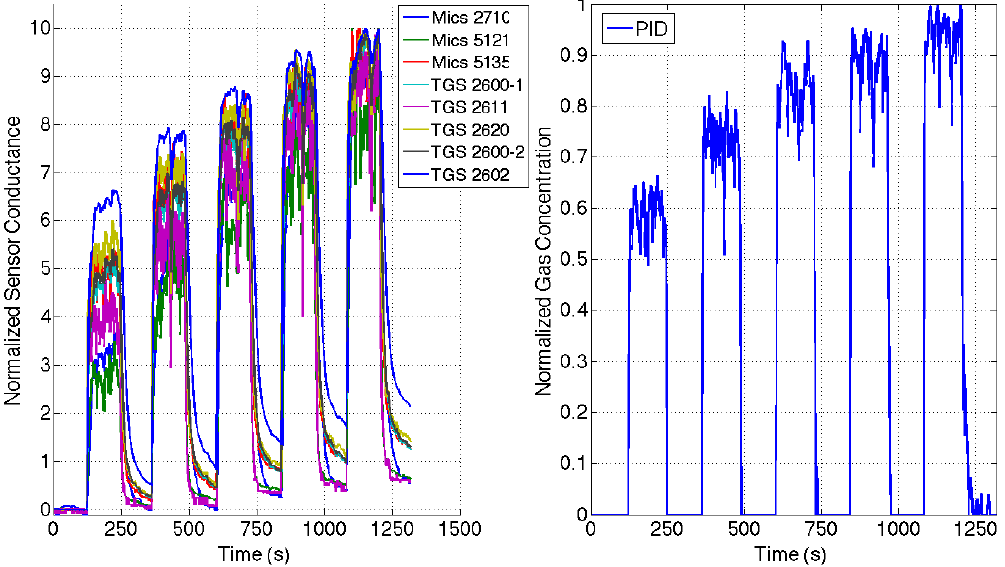
Figure 8. Pre-processed MOX and PID data for one trial of the Steps